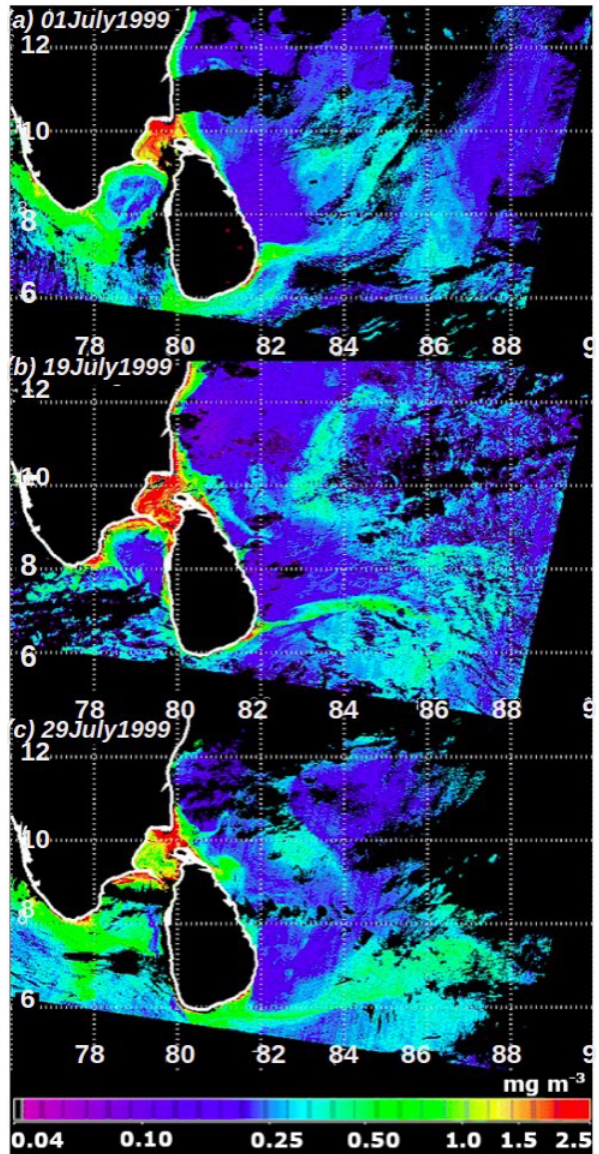
Figure 17. Chlorophyll a (mgm − 3 ) images around Sri Lanka for (a) 1 July 1999, (b) 19 July 1999, and (c) 29 July 1999 obtained from OCM aboard IRS-P4 Oceansat (from Vinayachandran et al.,